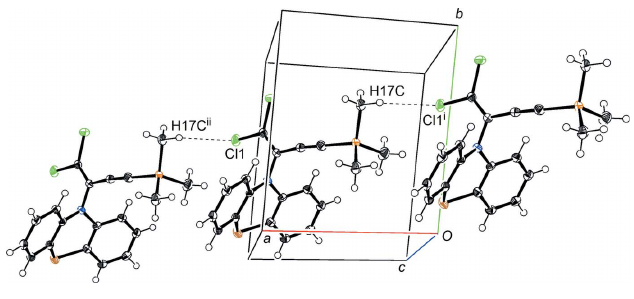
Figure 2 A view of the intermolecular interactions in the title compound